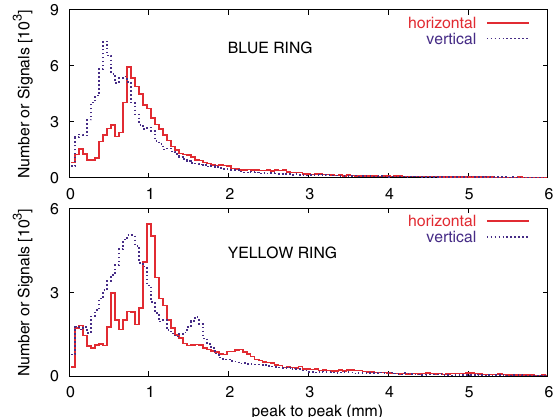
FIG. 5. (Color) Peak-to-peak values for all BPMs in all data